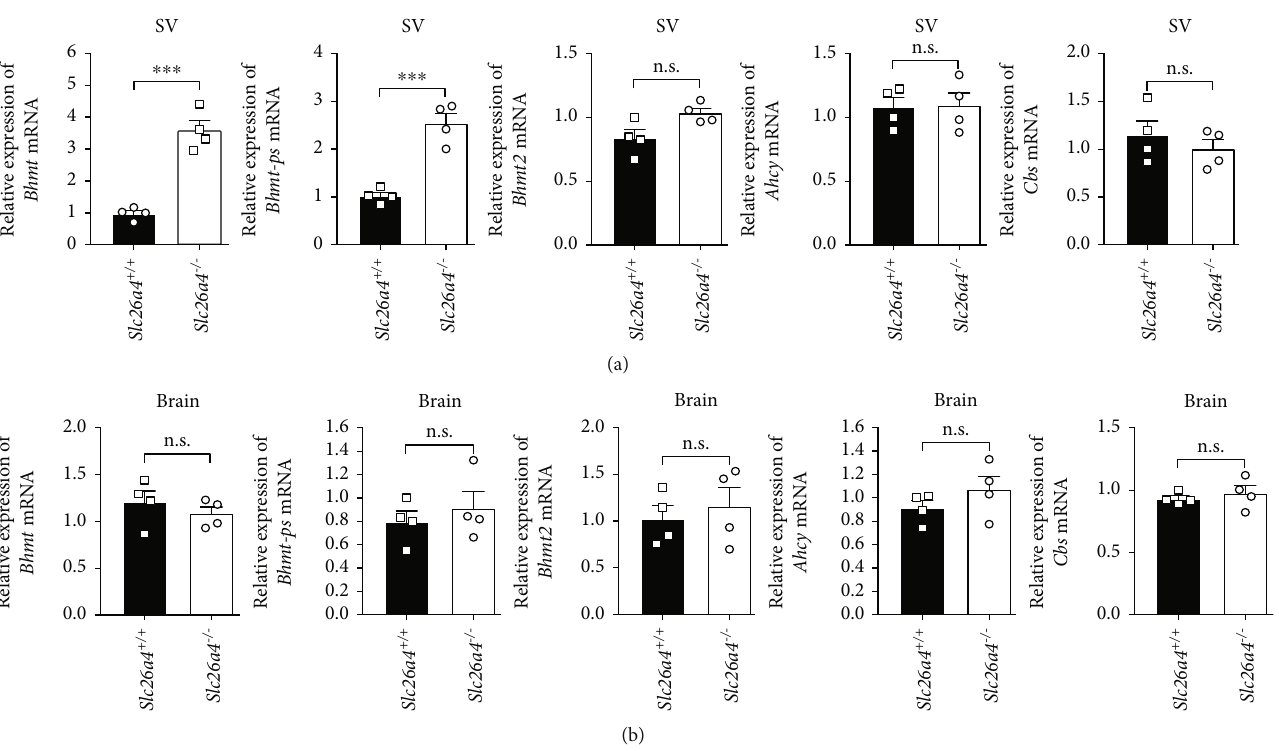
Figure 5: Altered expression of Hcy metabolism enzymes in Slc26a4 -/- SVs. (a, b) Quantitative RT-PCR analysis of expression of Hcy metabolism enzymes in Slc26a4 -/- SVs (a) or brains (b). n.s.: no signi fi cance. ∗ p < 0 : 05 and ∗∗ p < 0 : 01 by the unpaired t -test (c). Data